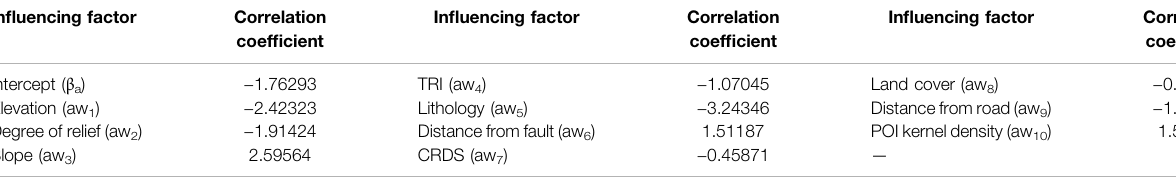
TABLE 4 | The correlation coef fi cients and function intercept values of LR ao .